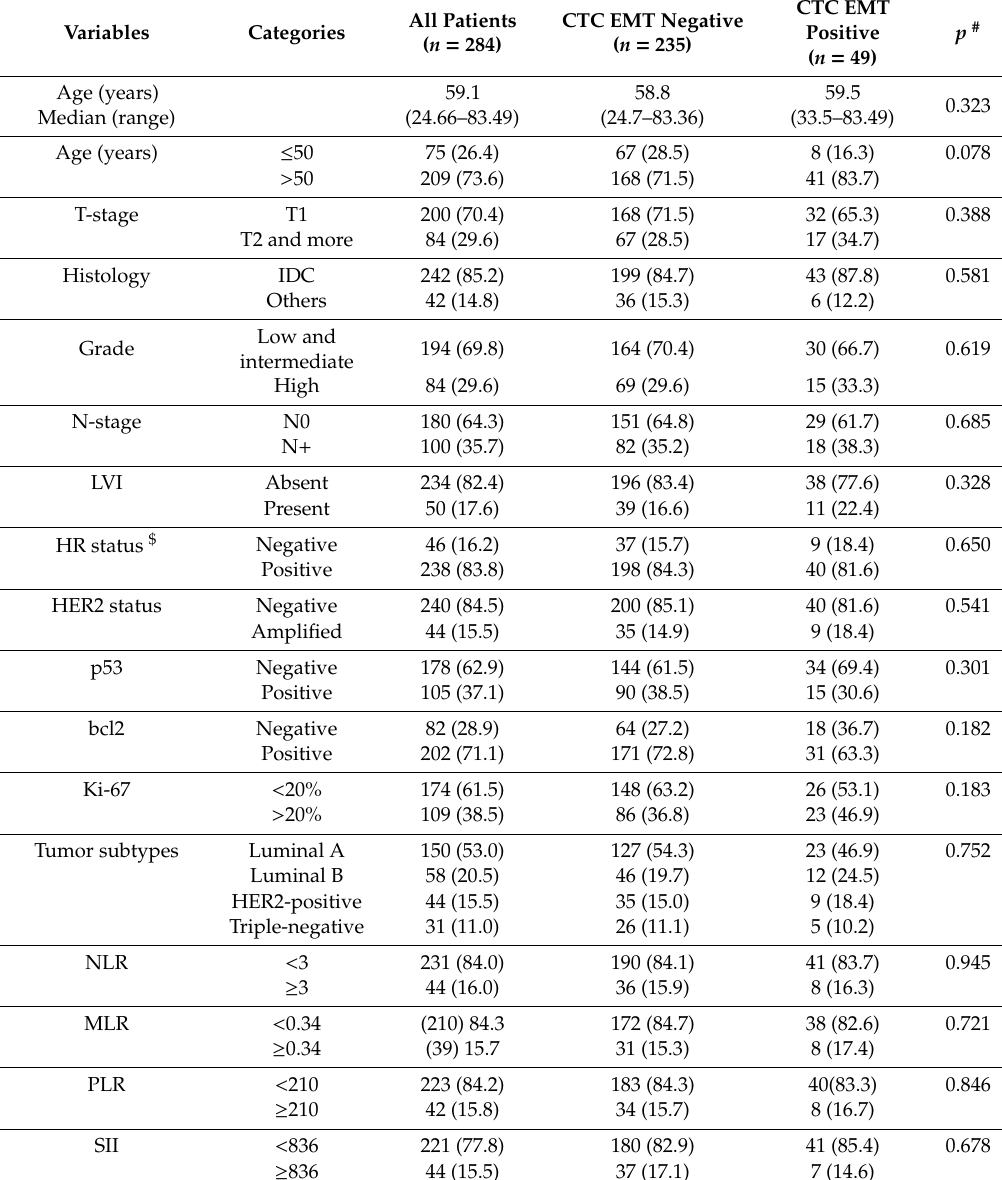
Table 1. Clinical characteristics of all CTC EMT-negative and -positive